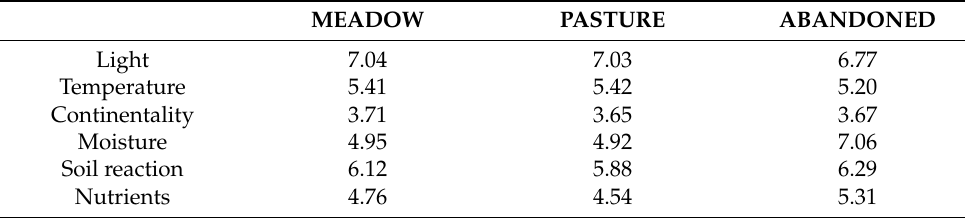
Table A1. Mean Ellenberg values per management